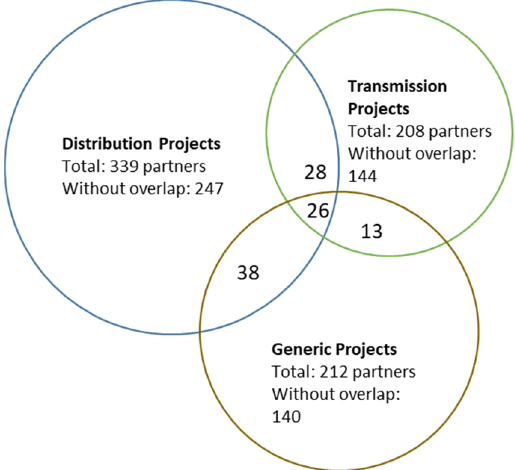
Figure 9. Overlaps between the participants in the three samples of FP7 projects.